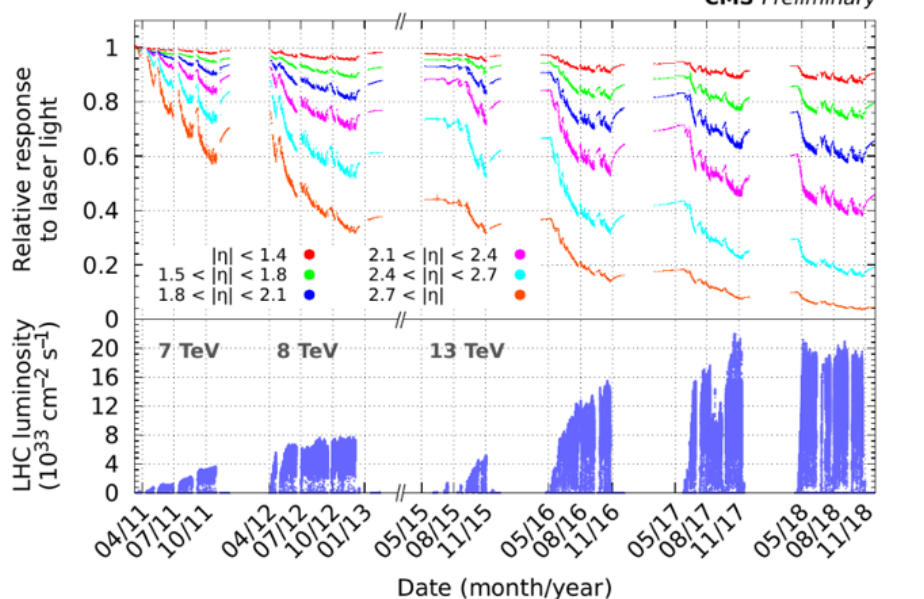
Figure 3. The relative response of the CMS ECAL to laser light and LHC instantaneous luminosity as a function of time plotted in different η ranges